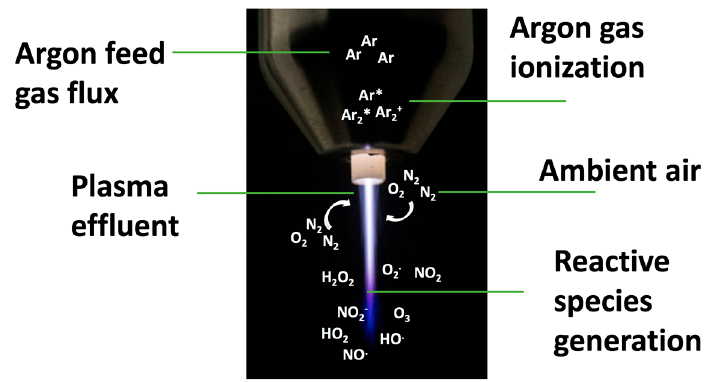
Figure 1. Principle of reactive species generation by cold physical plasma.